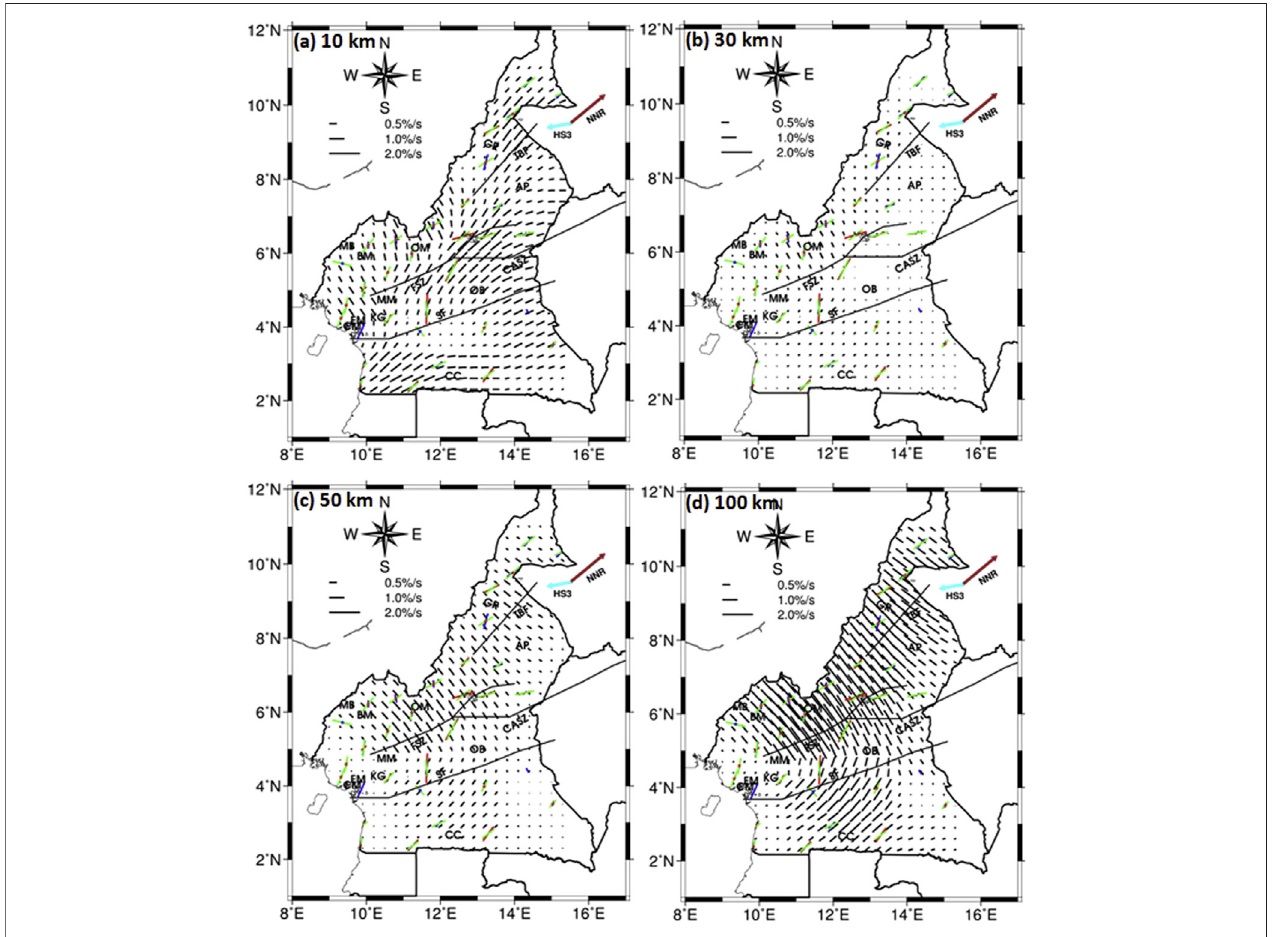
FIGURE 8 | Anisotropic fast directions within Cameroon. Black lines show azimuthal anisotropy from Rayleigh wave tomography at 10 km (A) , 30 km (B) , 50 km (C) , and 100 km (D) . Blue, red, and green lines show anisotropy from shear wave splitting from (Koch et al., 2012), De Plaen et al. (2014), and Elsheikh et al. (2014) respesectively. Reproduced with permission from Ojo et al.